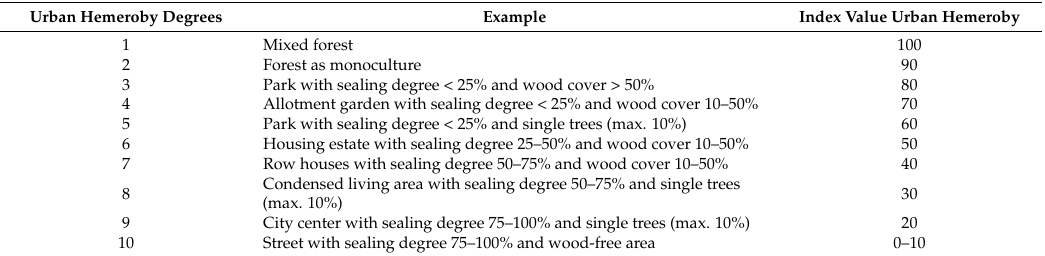
Table 5. Urban hemeroby degrees converted to urban normalized hemeroby index values for the ecosystem services assessment. Value 100 = highest ecosystem service capacity; 0 = lowest/no ecosystem service